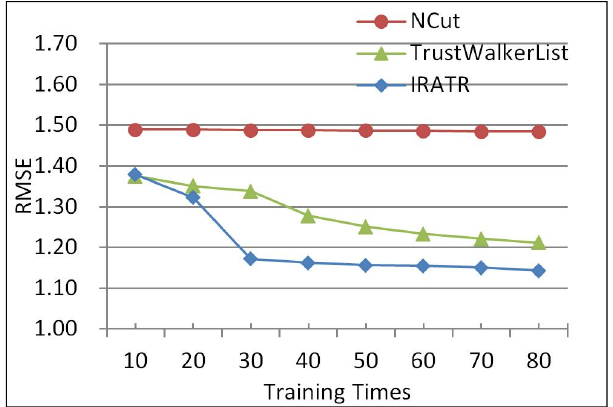
Figure 3. Comparison on cold start users.